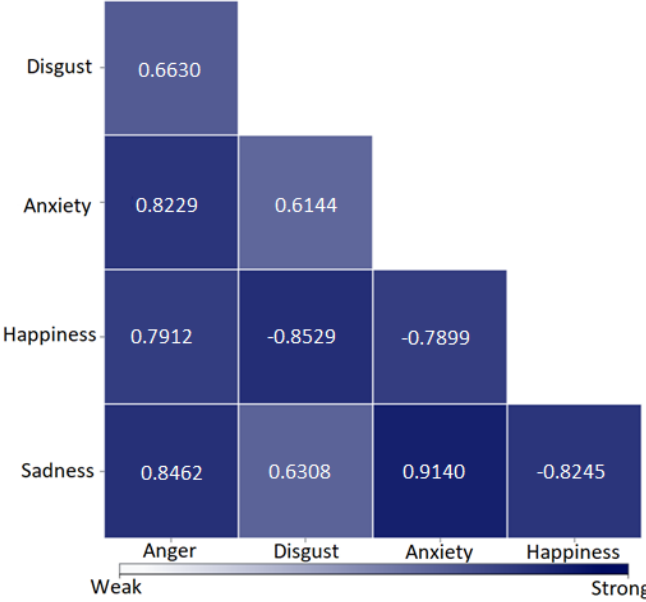
Figure 5. Correlation between measures in the group of healthy people.